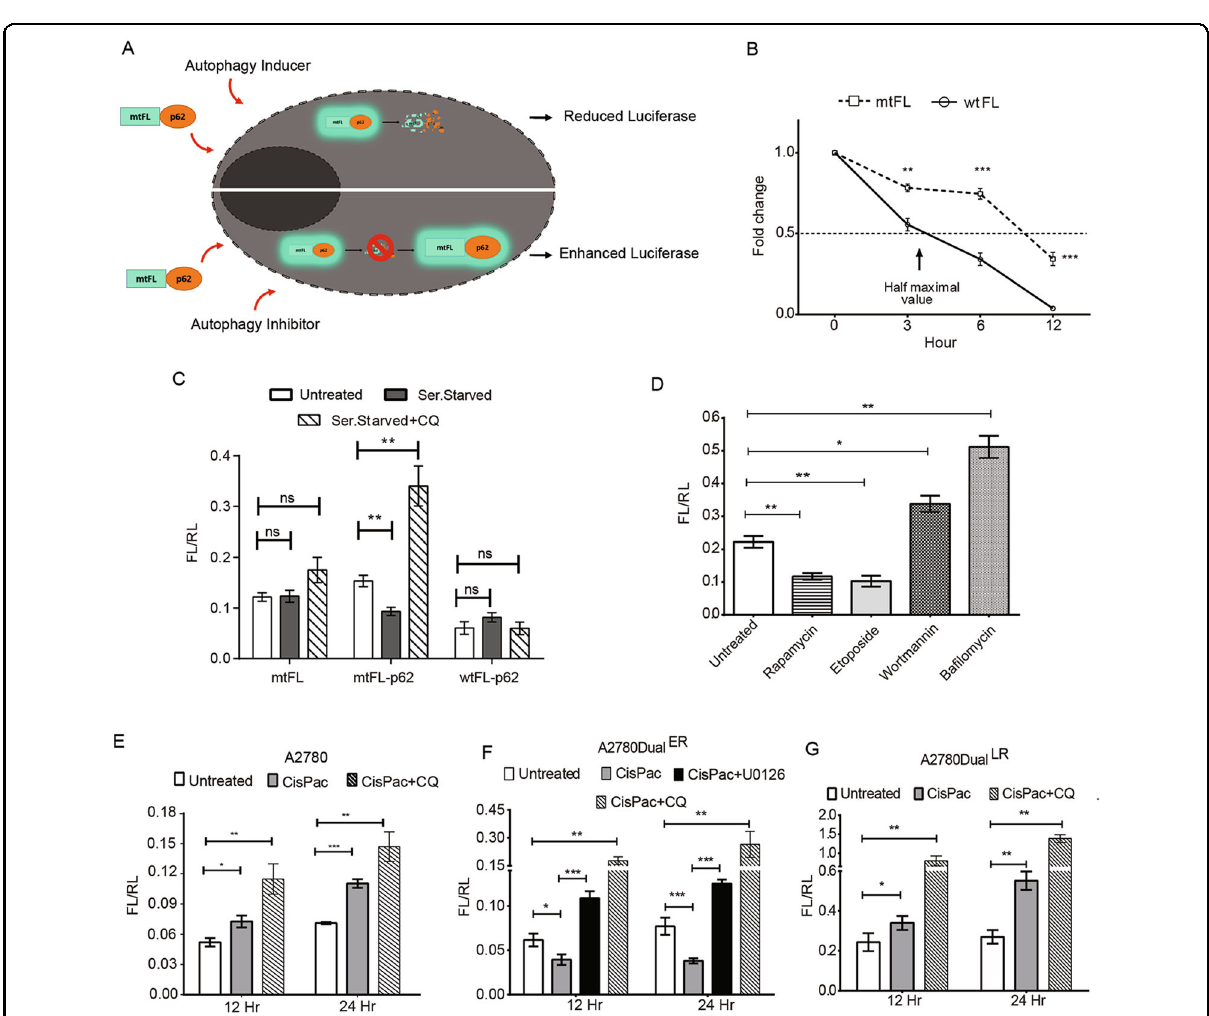
Fig. 4 Tracking kinetics of stress-induced autophagy fl ux using mtFL-p62 construct. A Schematic representation of the working principle of mtFL-p62 as an autophagy sensor. B Luciferase activity in A2780 cells transfected with either mutated thermostable fi re fl y luciferase (mtFL) or